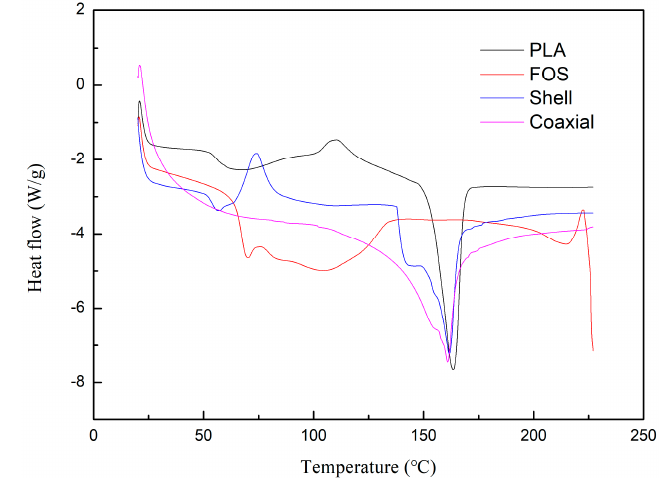
Figure 4. Differential scanning calorimetry (DSC) measurements of PLA, FOS, shell, and coaxial electrospinning nanofiber films.